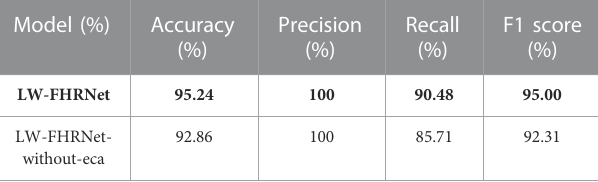
TABLE 4 Lightweight model performance comparison with and without the ECA module. Model (%)